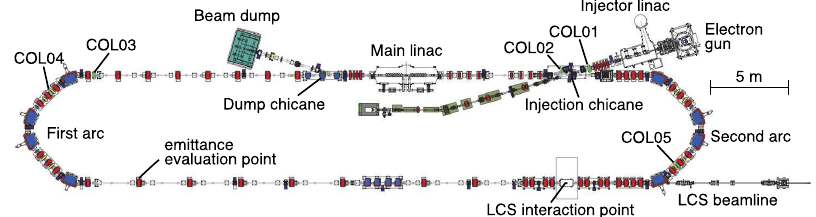
FIG. 3. Layout of the Compact ERL. COL1-COL5 are movable collimators to scrape off the beam